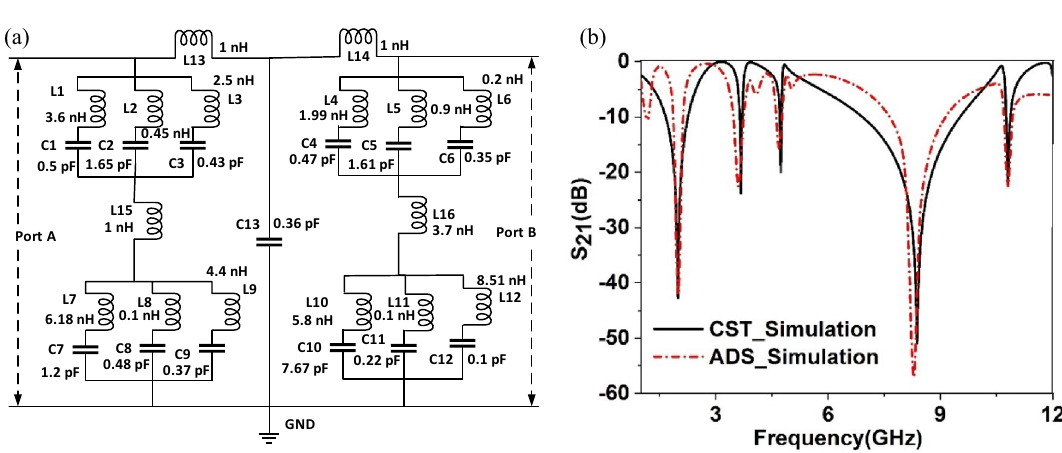
Figure 5. ( a ) MTM’s equivalent circuit, ( b ) S 21 plot of circuit simulation in ADS compared with 3D structural simulation in